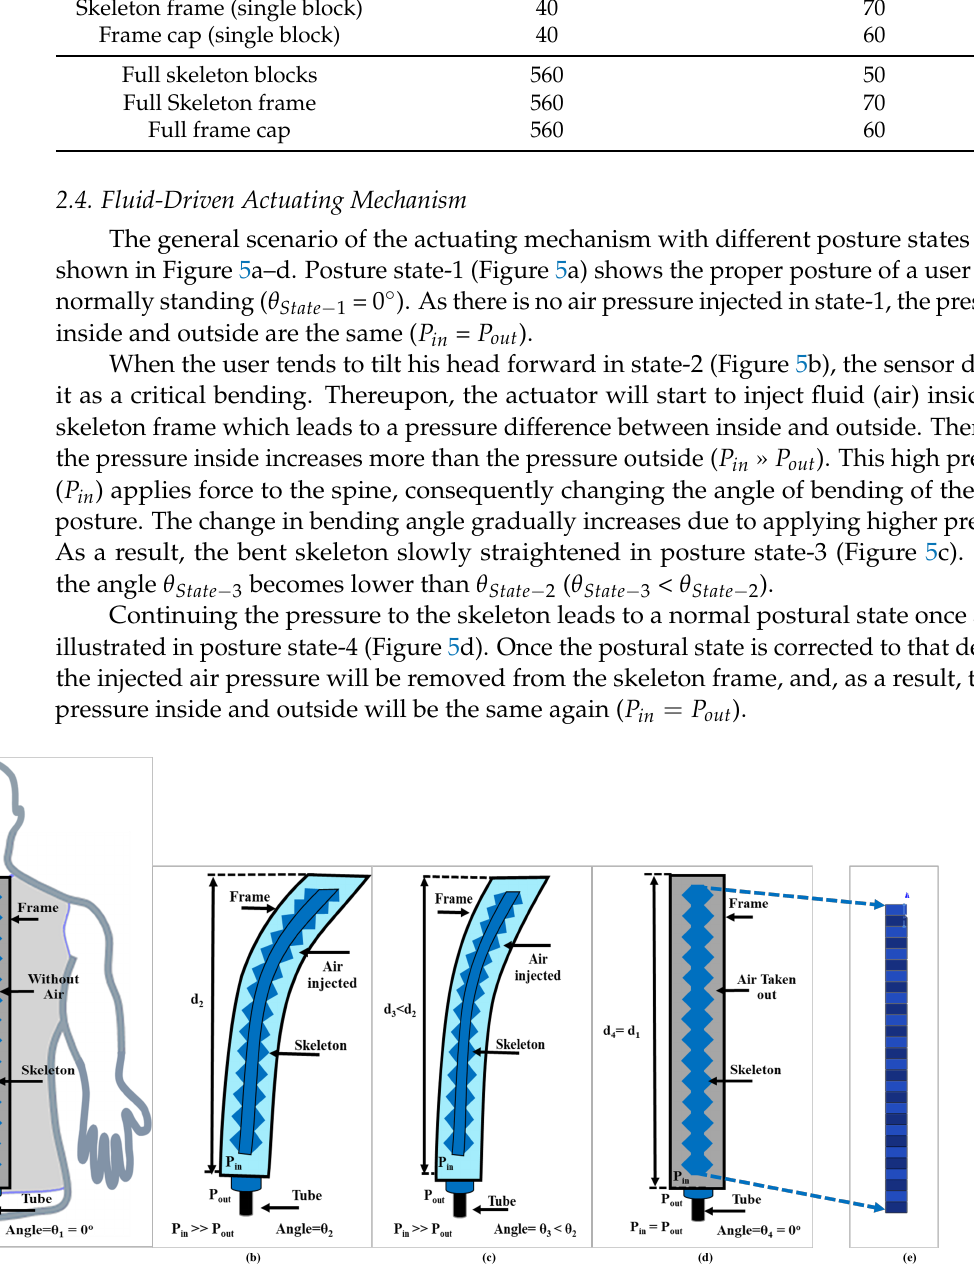
Figure 5. Illustration of the operating principle with the posture states ( a ) normal posture state, ( b ) bent spinal state with injected fluid, ( c ) recovery of spinal deviation as a result of fluid injection, ( d ) returning to original spinal state (fluid removed), and ( e ) skeleton side